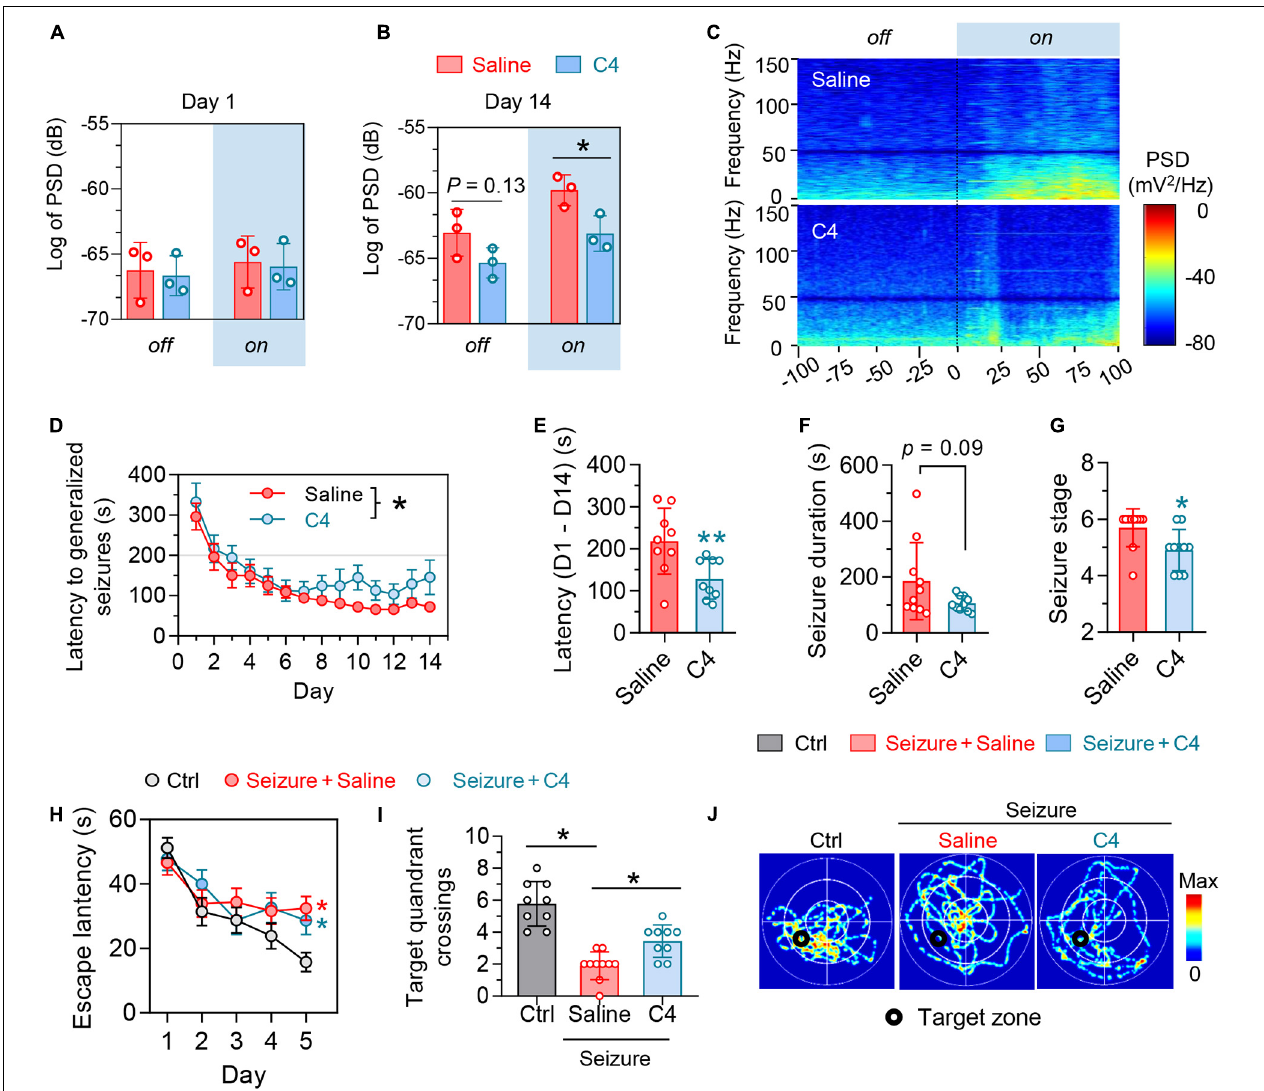
FIGURE 5 | Selectively facilitating tau degradation by C4 alleviates the optogenetics-induced epileptic seizures and the associated spatial memory deficits. (A–C) Blue light on did not change basal PSD in primary motor cortex (M1) at day 1, whereas C4 treatment significantly downregulated the PSD in M1 at day 14 during light-on. n = 3 mice in each group, unpaired t tests, * p < 0.05. (D,E) C4 prolonged the latency of generalized seizures of mice. n = 7–9 mice in each group. Repeated-measures ANOVA followed by Tukey multiple-comparisons tests, * p < 0.05. Unpaired t -tests, ** p < 0.01. (F,G) C4 tended to decrease the seizure duration and severity of seizure stages at day 14. Unpaired t tests, * p < 0.05. (H–J) C4 showed limited effect on improving the repeated seizures-induced spatial learning impairments in the water maze training phase. n = 9–10 mice in each group. Repeated-measures ANOVA followed by Tukey multiple-comparisons